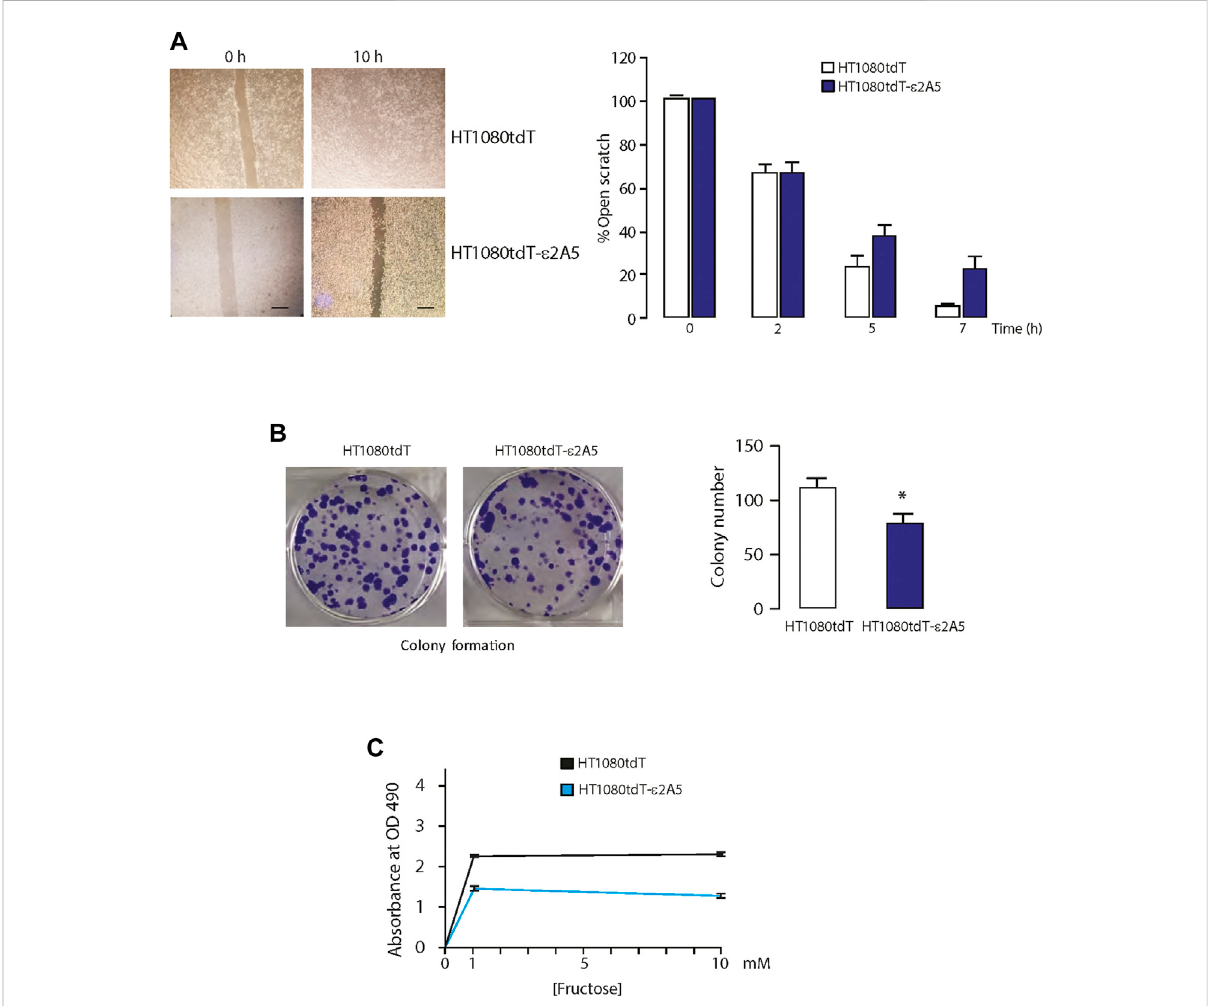
FIGURE 3 Attenuation of theSLC2A5 gene expression in fi brosarcoma cells. (A) . Images ofscratch test(left) andquantitativeanalysis of closure (right) as a function of time for HT1080tdTand HT1080tdT- ε 2A5 fi brosarcoma cells (n = 3). Scale bar 10 µm. (B) . Imagesof colonies formedby HT1080tdT and HT1080tdT- ε 2A5cellsandanalysis ofcolony number(500cells/well platedattime0 h).* p =0.007;n=3.Colonies were fi xedwith70%ethanoland visualized by staining with 1% trypan blue. (C) . Proliferation assay of HT1080tdT and HT1080tdT- ε 2A5 cells. HT1080tdT and HT1080tdT- ε 2A5 cellswereplatedatadensityof5.0×10 3 cells/wellofa96wellplates.FructosewasaddedtothemediaasindicatedintheFigure.Cellswerecultured for 48 h followed by MTS assay (n = 3). All data in the Figure is representative of more than 3 experiments with 3 biological